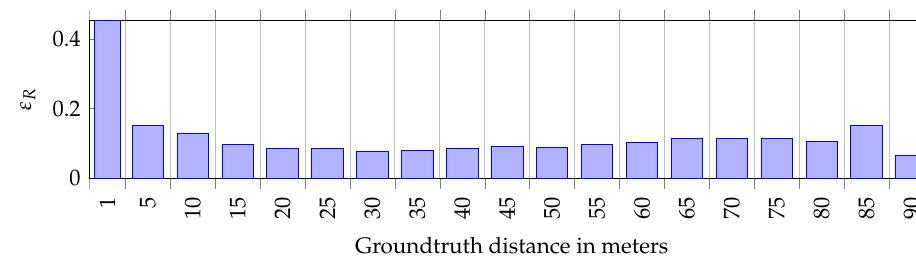
Figure 3. Dependency of ε A on the object’s distance.